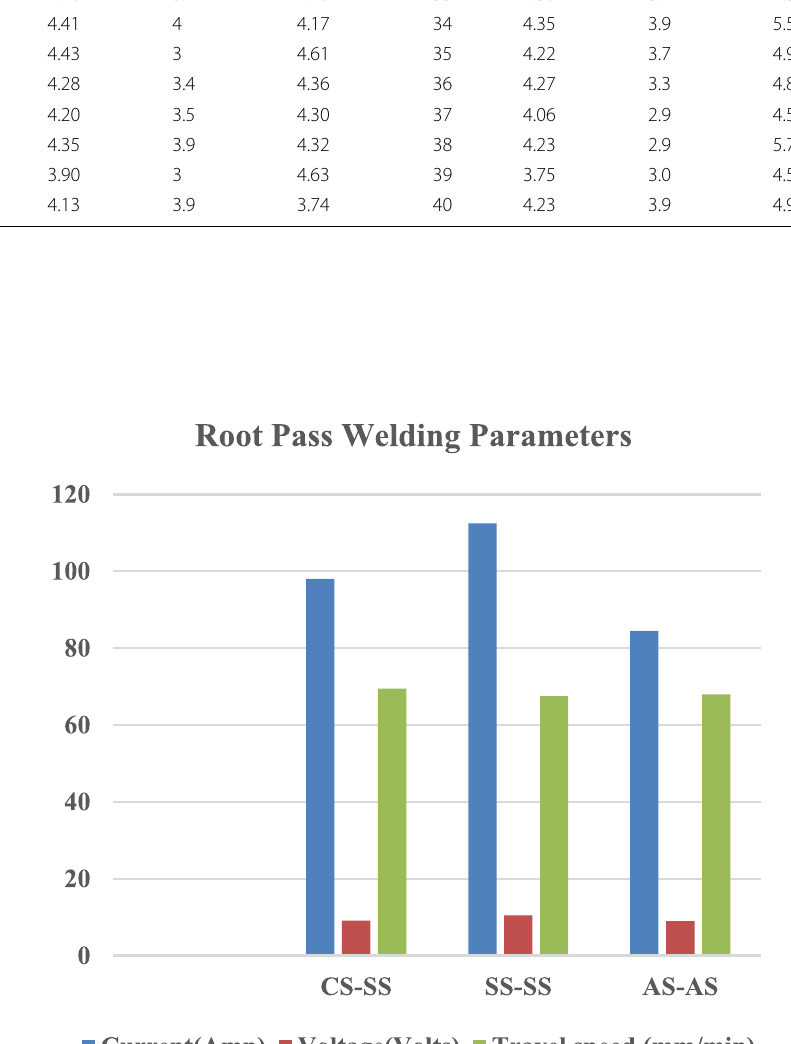
Fig. 5 Root pass welding